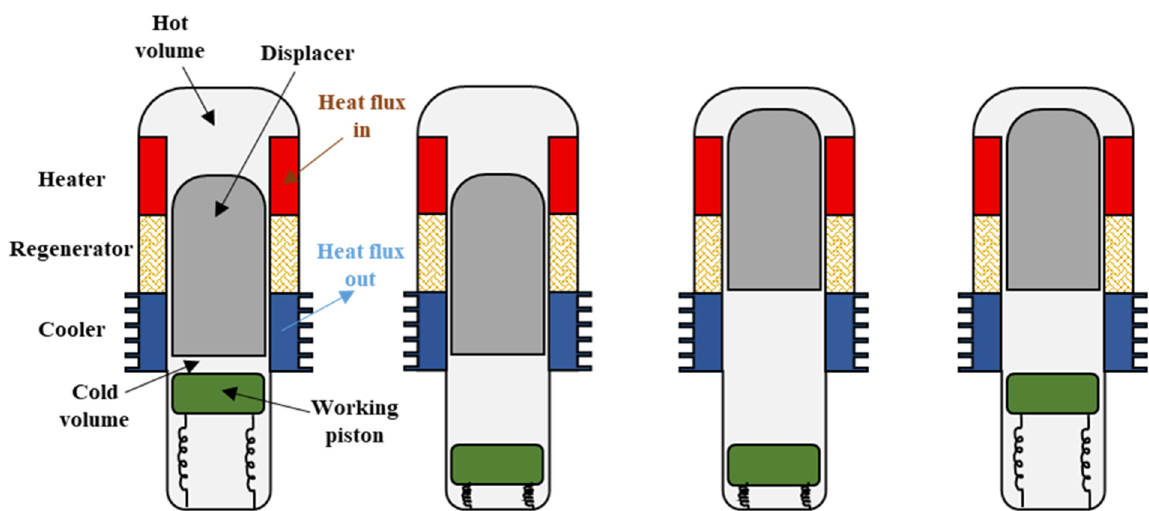
Figure 1. Operation mode of a FPSE [26].